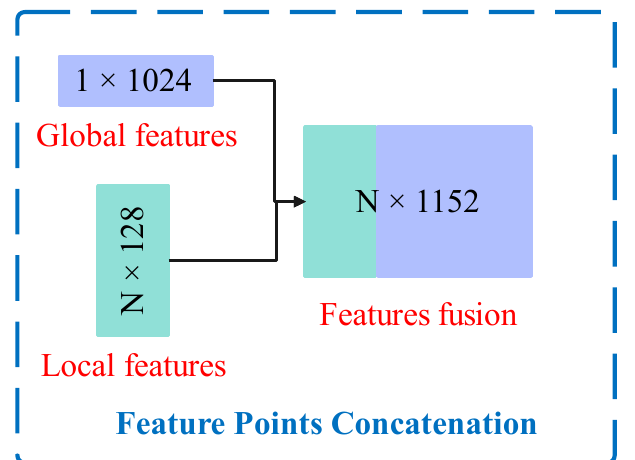
Figure 7. The procedure of multi-machining feature segmentation and recognition.